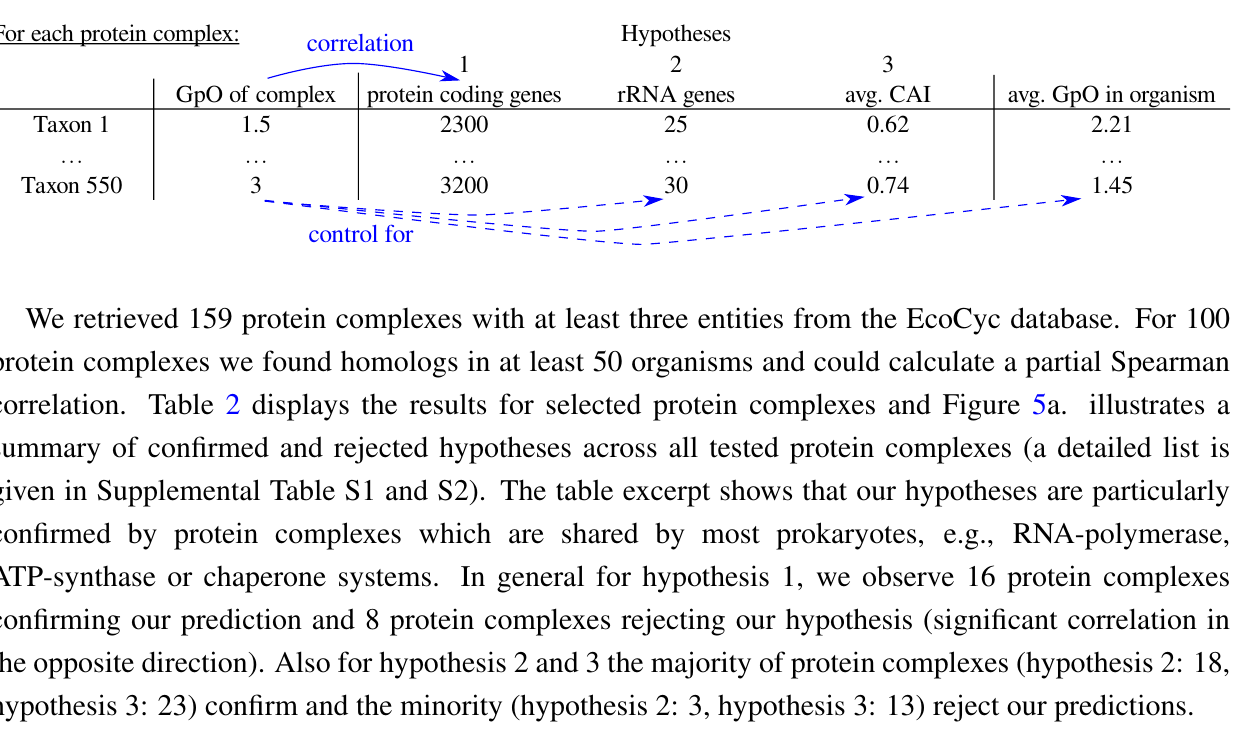
Table 1. Determination of partial correlations (values chosen arbitrarily). Arrows in blue show the procedure of the determination of partial correlations for hypothesis 1. Spearman correlation between GpO and Hypothesis 1 is calculated while controlling for the other quantities (dotted